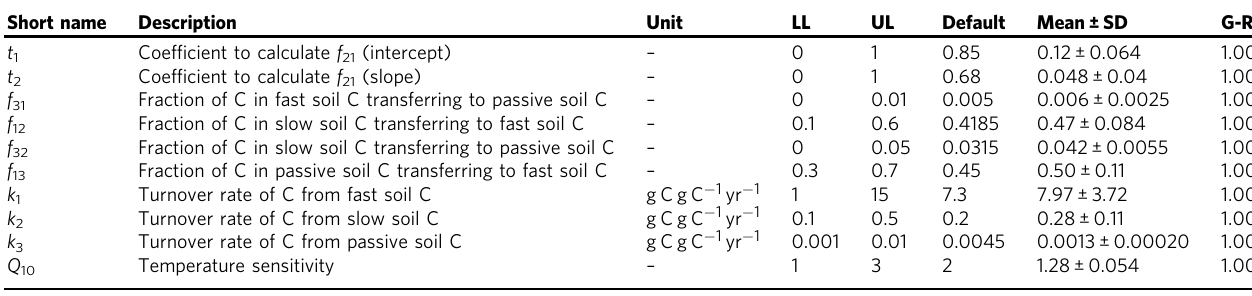
Table 1 Descriptions of parameters in the conventional model